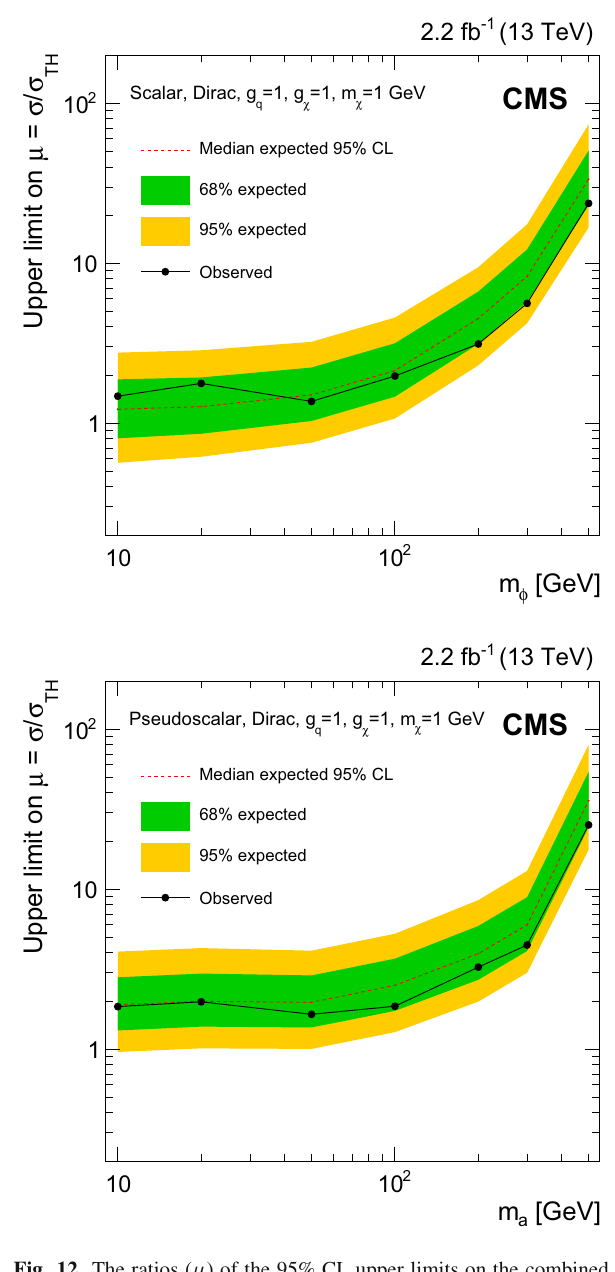
Fig. 12 The ratios ( μ ) of the 95% CL upper limits on the combined tt + χχ and bb + χχ crosssectiontosimplifiedmodelexpectations.The limits are obtained from combined fits to the tt + p miss signal and background control regions for the hypothesis of a scalar mediator (upper) and a pseudoscalar mediator (lower). A fermionic DM particle with a mass of 1 GeV is assumed in both panels. Mediator couplings correspond to g q = g χ =